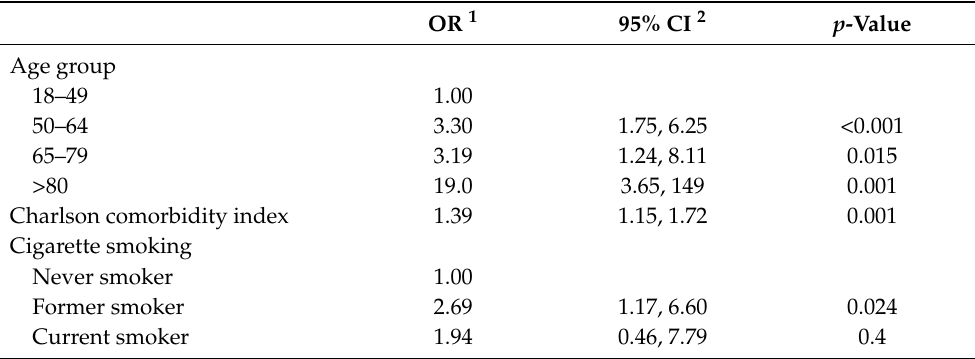
Table 2. Risks factors associated with hospital